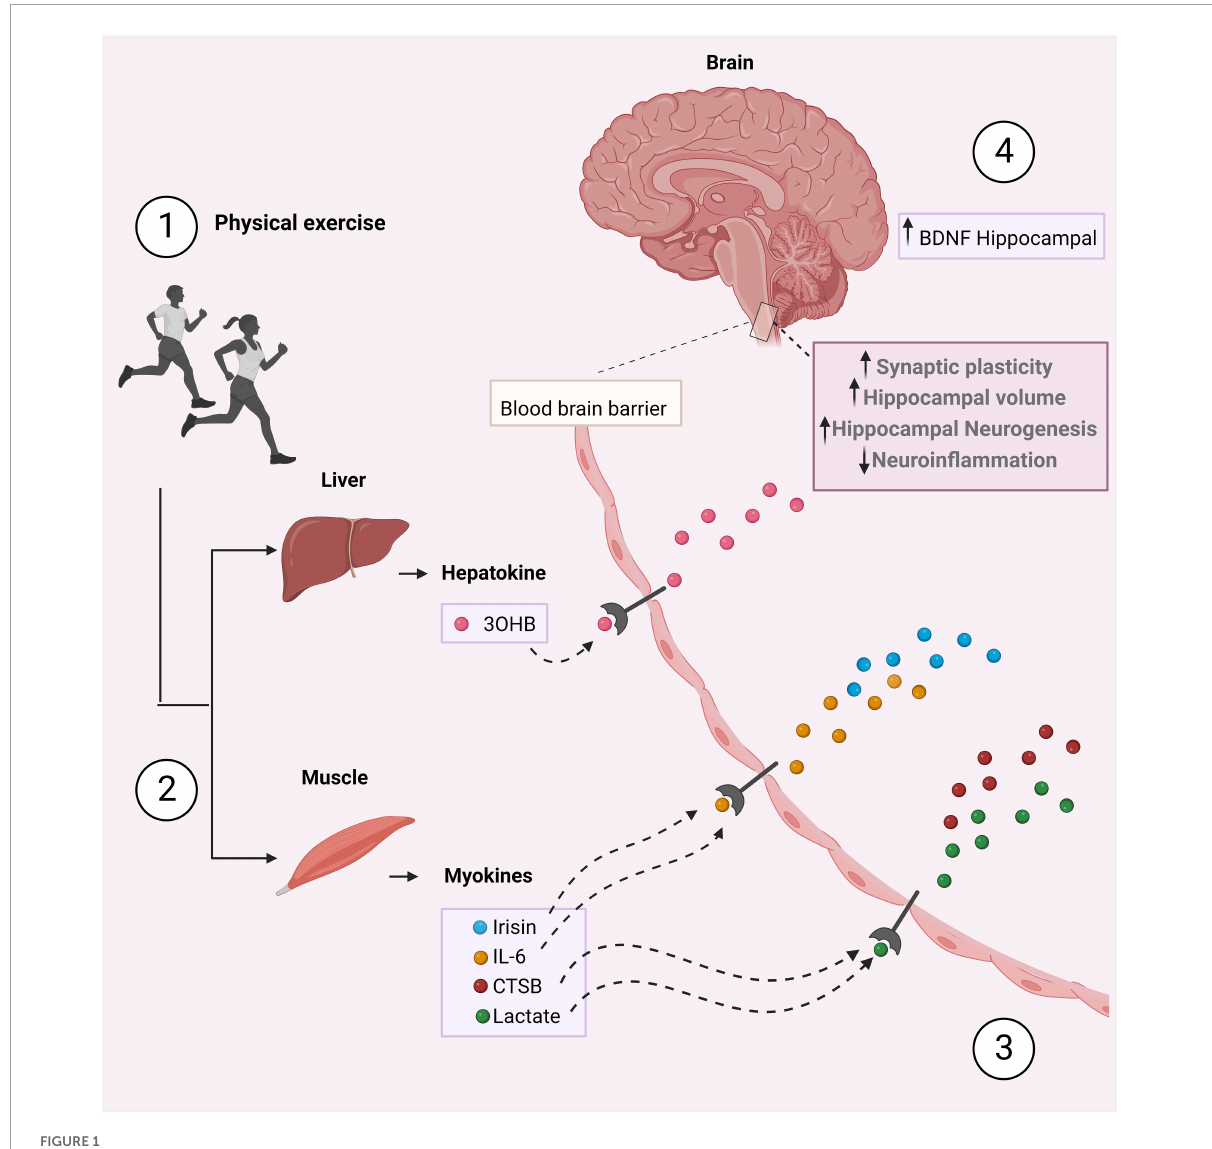
FIGURE1 The crosstalk between the periphery and the brain stimulated by physical exercise. (1) During physical exercise, peripheral tissues secrete exerkines, such as irisin, IL-6, CTSB, 3OHB, and lactate which mediate the beneficial effects of exercise (2). These exerkines cross the BBB (3), increase BDNF levels, hippocampal volume and neurogenesis, and decrease neuroinflammation (4). As a result, improved synaptic plasticity and memory occurs. Figure was created with